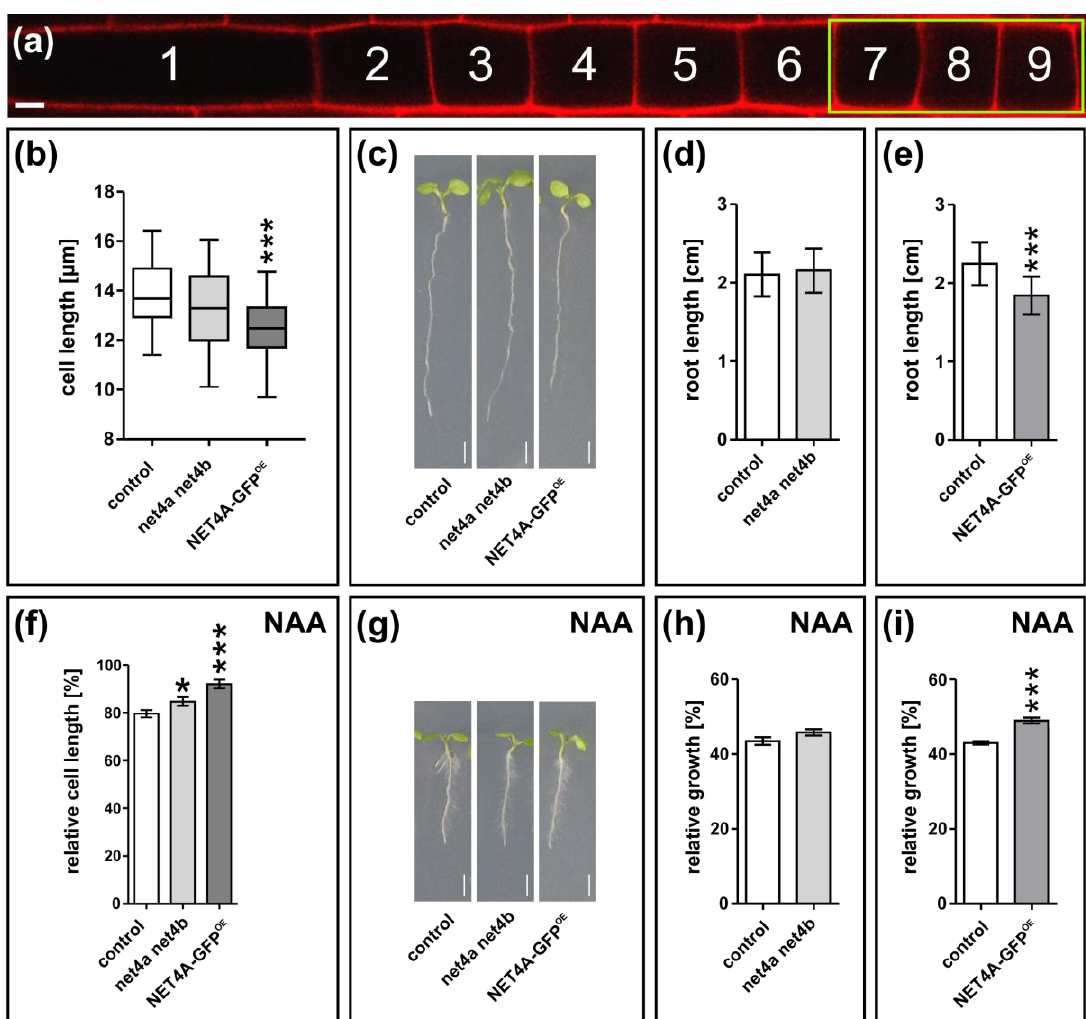
Figure 4. NET4A-dependent compacting of the vacuole correlates with reduced cell size and root organ growth. ( a ) Representative atrichoblast cell file for cell length quantification. The green box marks the three quantified cells per file (7 to 9). ( b ) Cell length of the net4a net4b ( n = 81) double knockout line and of the NET4A-GFP line driven by the 35S promoter (NET4A-GFP OE ; n = 72) in respect to the control ( n = 147). ( c–e ) Root length of the net4a net4b ( n = 27) double knockout and the NET4A-GFP OE ( n = 24) lines in respect to the corresponding control ( n = 29 and n = 52). One representative experiment is shown. ( f ) Auxin-dependent (200 nM NAA, 20 h) relative cell length of the double knockout ( n = 81) and NET4A-GFP OE ( n = 81) in comparison to the control ( n = 147). ( g – i ) Relative root length of the control ( n = 27 and n = 50), net4a net4b ( n = 29) and NET4A-GFP OE ( n = 26) upon auxin treatment (125 nM NAA, 6 d). One representative experiment is shown. Columns of bar charts represent mean values, error bars display s.e.m. Box limits of boxplots represent 25th percentile and 75th percentile, horizontal line represents median. Whiskers display minimum to maximum values. Student’s t -test, p -values: * p < 0.05; *** p < 0.001. Scale bar: 5 µm.